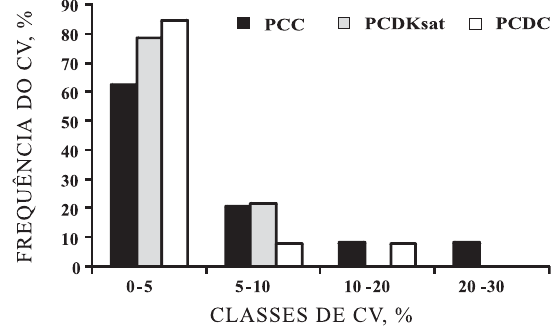
Figura 3. Distribuição do coeficiente de variação (CV) por classes. PCC: permeâmetro de carga constante; PCDKsat: permeâmetro de carga decrescente associado ao Ksat; e PCDC: permeâmetro de carga decrescente e cronômetro